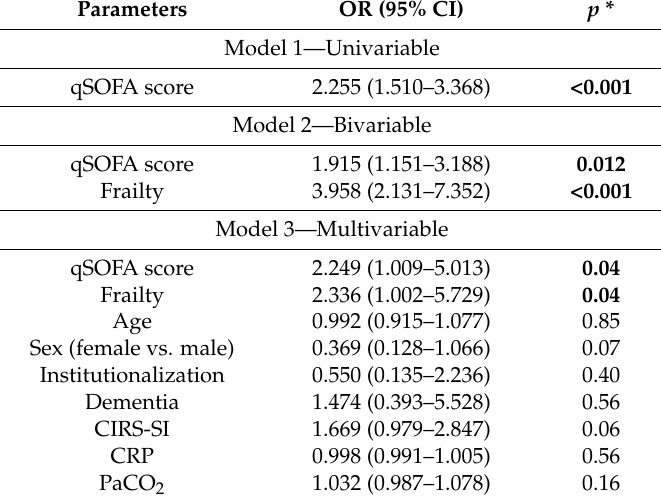
Table 4. Logistic regression analysis showing the association of qSOFA score at admission with the secondary study outcome (pooled mortality three months after discharge) in elderly patients with suspected sepsis who completed the study follow-up ( n = 247).